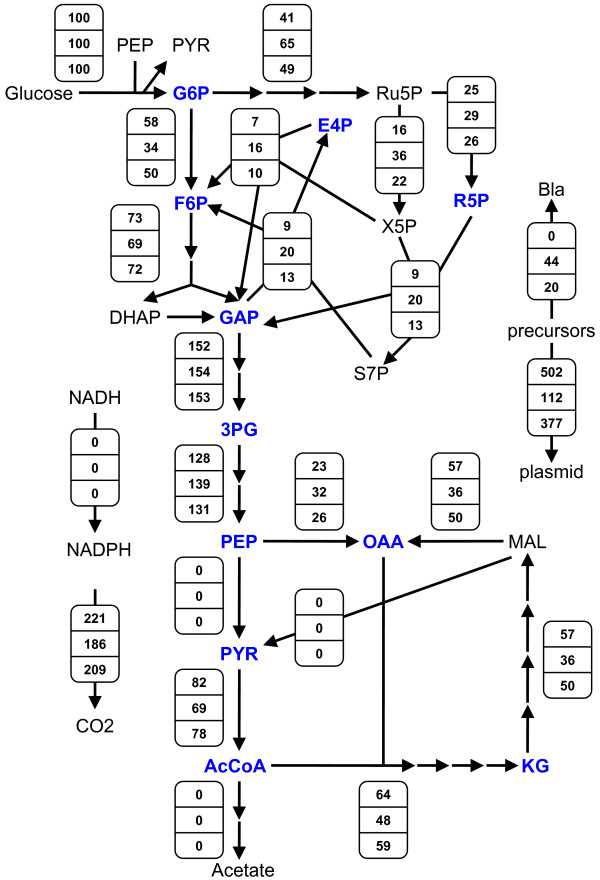
Optimal carbon flux distributions for maximum plasmid production in E. coli. In all three distributions,rtranshydrogenase was constrained to zero, while racetateand rPyk were not constrained. Distributions vary by their assigned value of α in Equation (5) and/or whether or not a limit was imposed on Bla production. Top:α = 0. Middle:α = 250; unlimited Bla production. Bottom:α = 250; Bla production limited to 20% of total protein (Equation (7), f = 0.20). For simplicity, the network in Fig. 1 has been condensed and fluxes (mmol/g/h) have been expressed as % of glucose uptake, except rBla (expressed as % of total protein) and rplasmid (expressed as yield in mg/g). The production of lactate and succinate have also been omitted, as these fluxes were nil for all distributions.